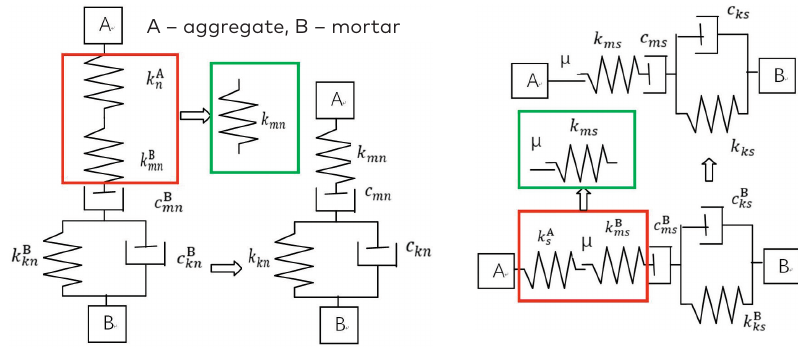
Figure 3. Conversion between mortar and aggregate, the Burger